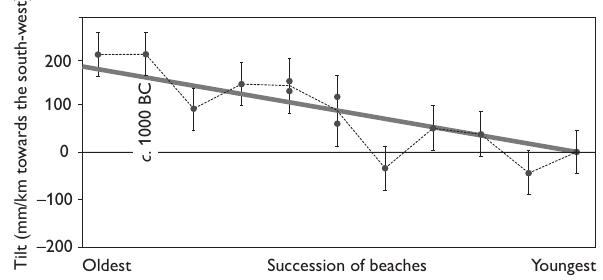
Fig. 4. Slopes of successive beach terraces of diminishing age to the right, with estimated standard errors. When standard errors are introduced in this Fig. 5 of Hansen (1980) it is obvious that abrupt changes of slopes are not significant. The slope readings are just as well explained by a steady change of slopes, approximated by the thick sloping line generally inside one standard error and certainly within two standard